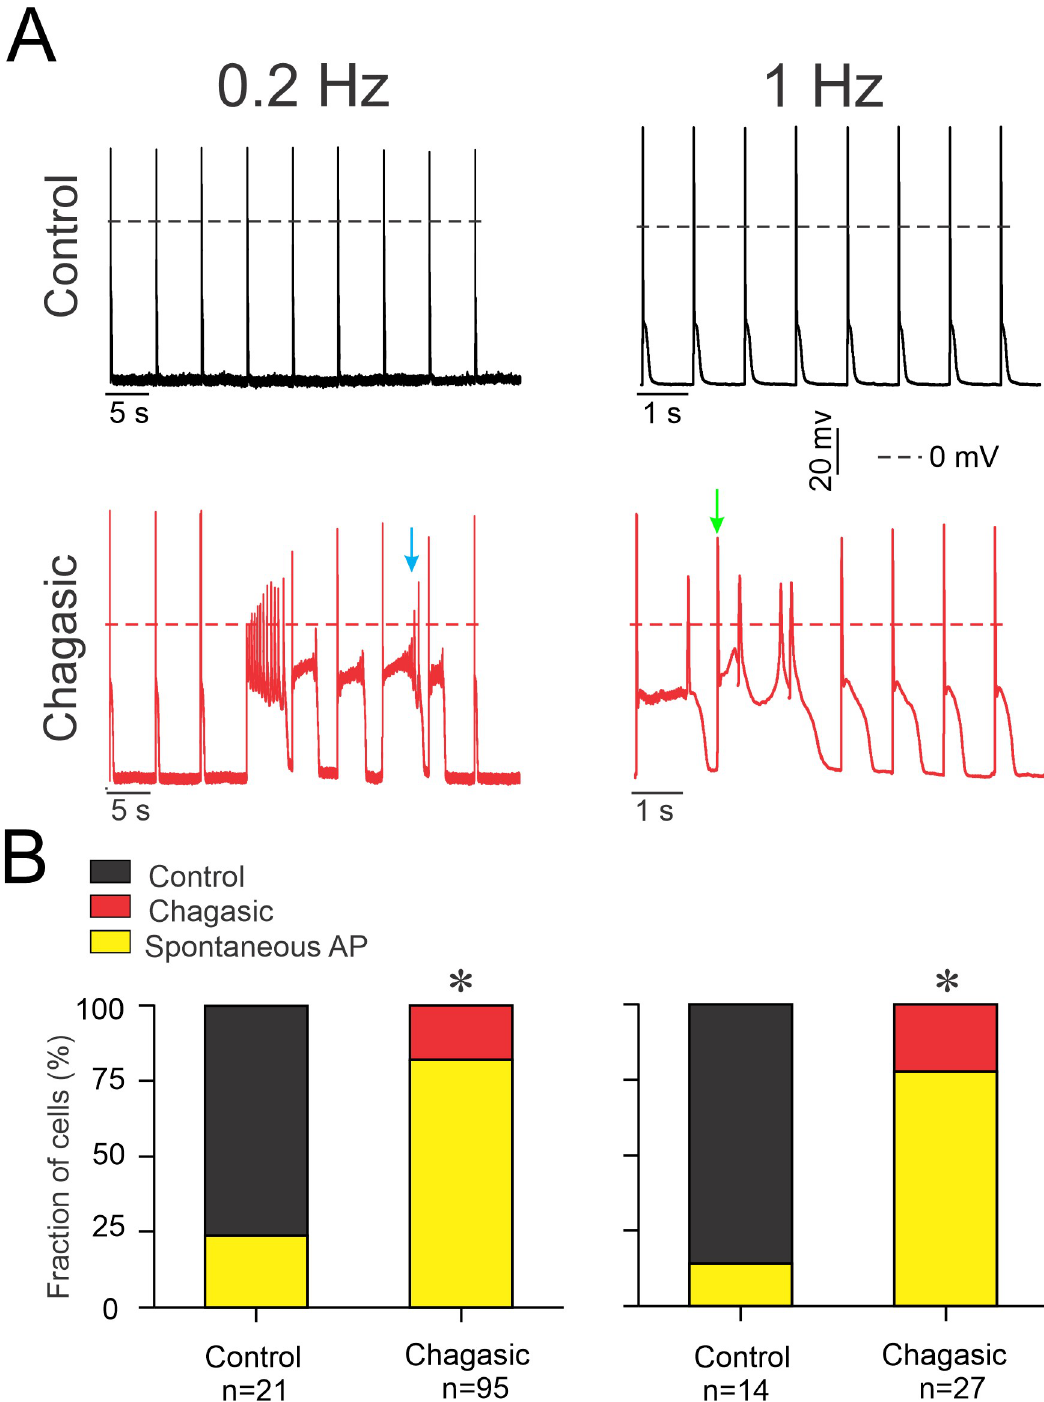
Fig 2. Membrane potential instability due to after-depolarization events in the chronic phase of experimental Chagas disease. (A) Eight to nine consecutive recorded action potentials from control and infected isolated cardiomyocytes paced at 0.2 Hz and 1 Hz. (B) The fraction of cells displaying membrane potential instability triggered by after-depolarizations, either during membrane repolarization (exemplified by the blue arrow) or after full membrane repolarization (exemplified by the green arrow). Data were compared using Fisher’s exact test. n represents the number of cells. � p <